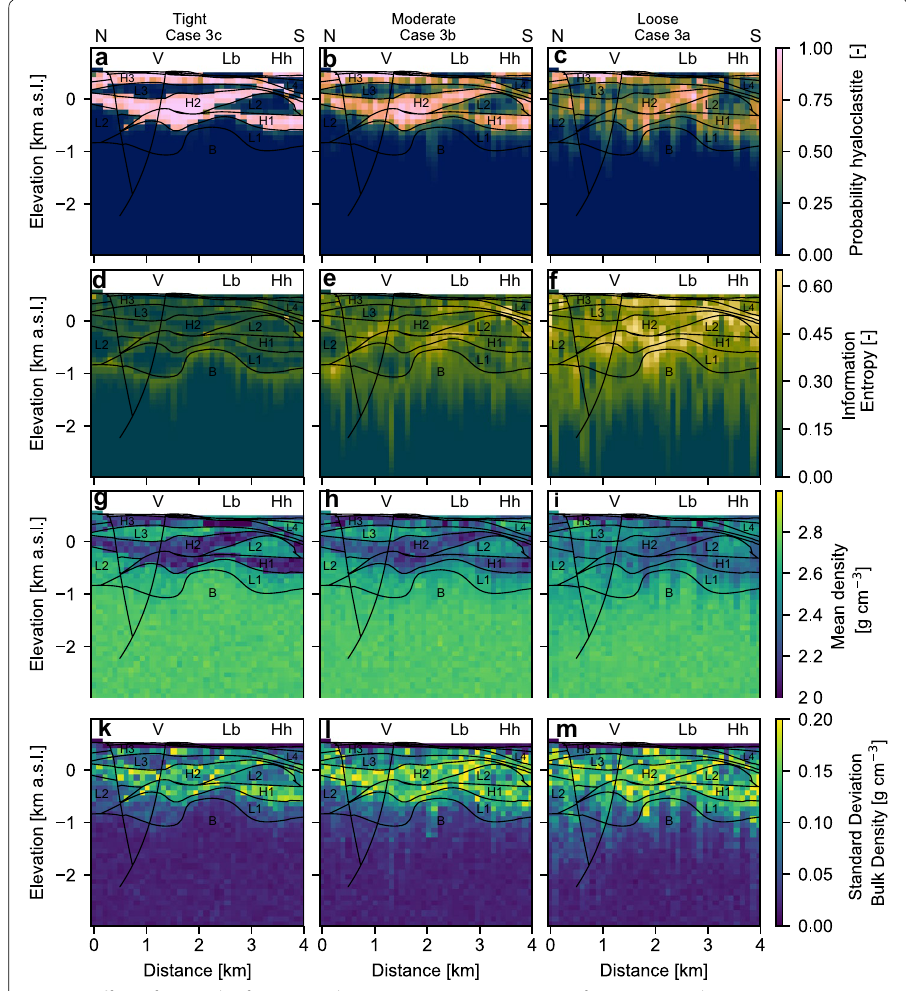
Fig. 11 Effect of strength of commonality constraint on uncertainty of posterior results (Case 3a–c). Posterior results for ( a – c ) probability of hyaloclastite and ( b – d ) information entropy, ( g – i ) mean bulk density and ( k – m ) standard deviation of bulk density, for inversion runs with ( a , d , g , k ) tight commonality constraint (Case 3c), ( b , e , h , l ) moderate commonality constraint (Case 3b), ( c , f , i , m ) loose commonality constraint (Case 3a). Results are shown along Section